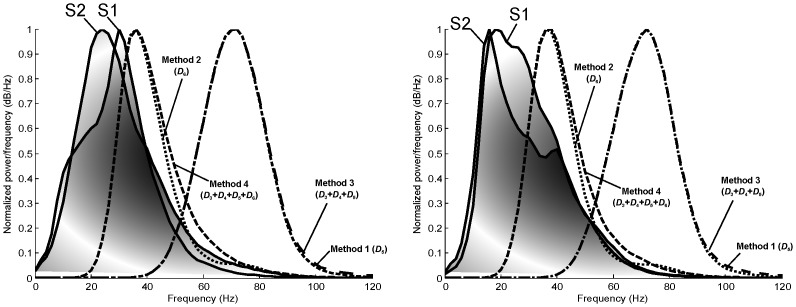
Power spectrum of S1 and S2 segments compared to the power spectrum of wavelet details used in all methods at the second intercostal space (left) and apex (right).A total of 284 heart beats used in this analysis for subjects with mean PAp > = and < 25 mmHg. Note, the sampling frequency of the heart sounds is 4000 Hz.